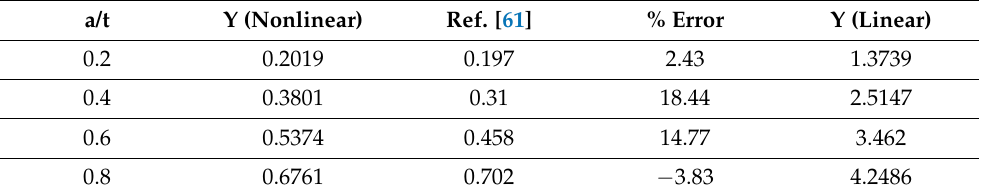
Figure 15. Stress intensity factor for thin-walled composite cylinder under internal pressure. Table 3. Influence coefficients Y for stress intensity factor with linear and nonlinear curve fitting.